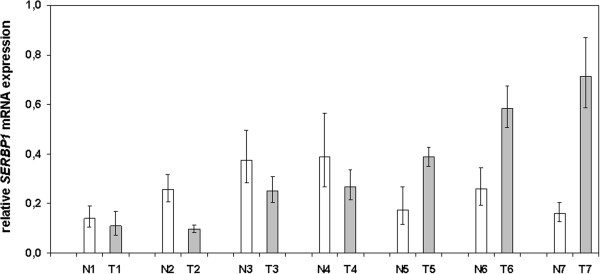
SERBP1 is not differentially expressed between normal and malignant human breast tissue in matched pairs. A collection of cryoconserved matched pairs of normal (N; n = 7) and cancerous breast tissues (T; n = 7) was analysed for SERBP1 expression by semiquantitative realtime PCR. SERBP1 RNA was upregulated in three tumour tissues compared to the corresponding normal breast tissues. In four cancerous tissues SERBP1 expression was lower than in the corresponding normal breast tissue. Expression levels between the respective groups were statistically not significant (P = 0.56).